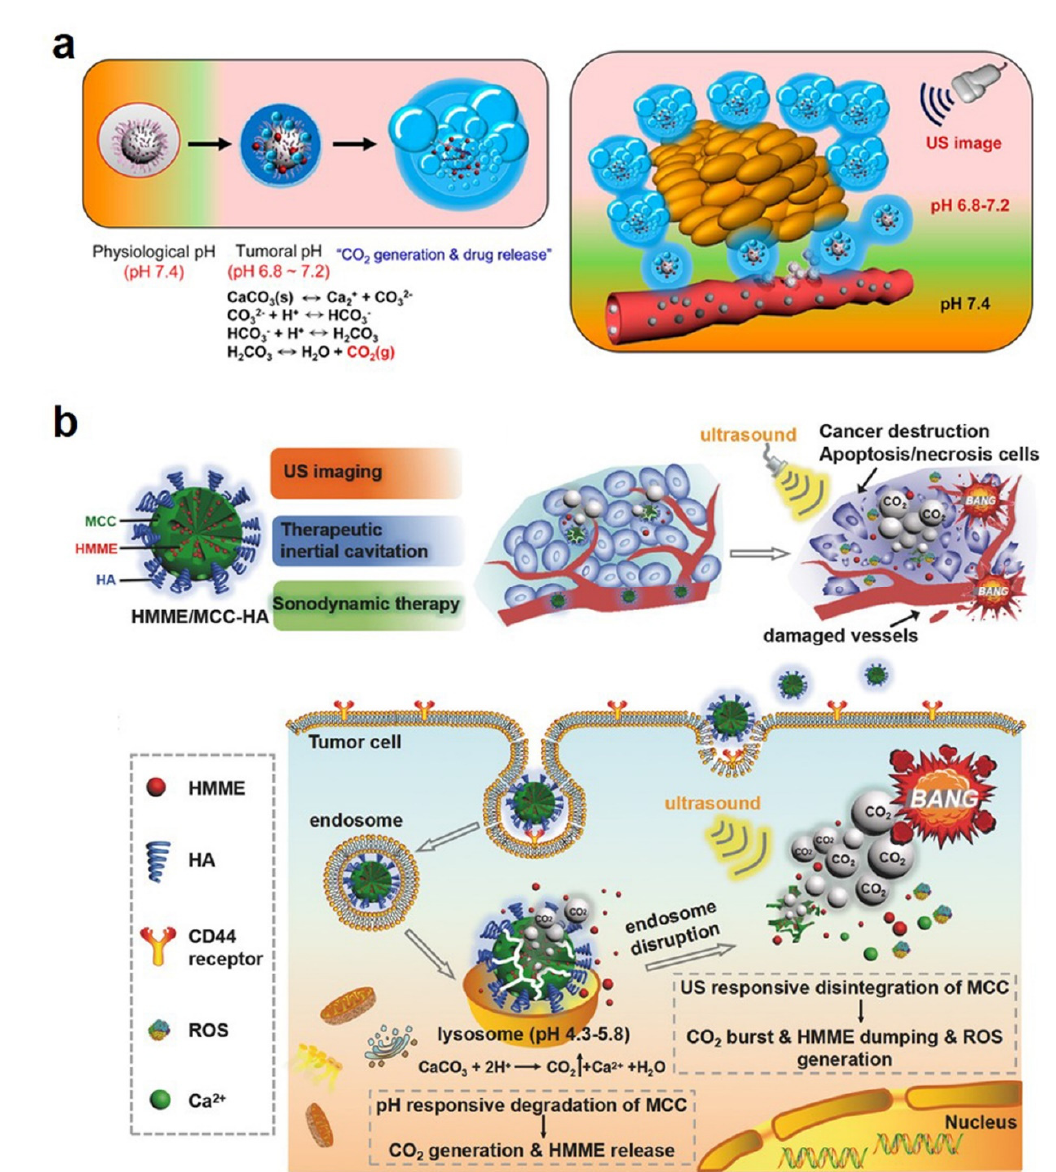
Figure 7. ( a ) Bubble generation and drug release of the designed CaCO 3 NPs. Reprinted with permission. Copyright 2015, American Chemical Society [45]. ( b ) Schematic illustration of the US imaging-guided cavitation/sonodynamic combined therapy. Reprinted with permission. Copyright 2017, Wiley-VCH [48].